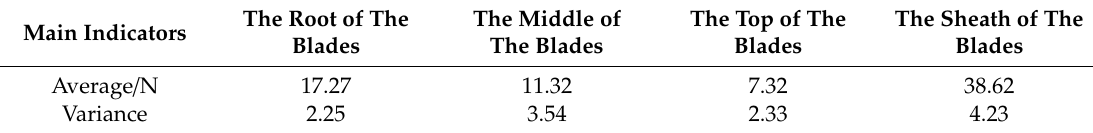
Table 5. Main data of three-point stretching of the blades at normal temperature. The Root of Main Indicators